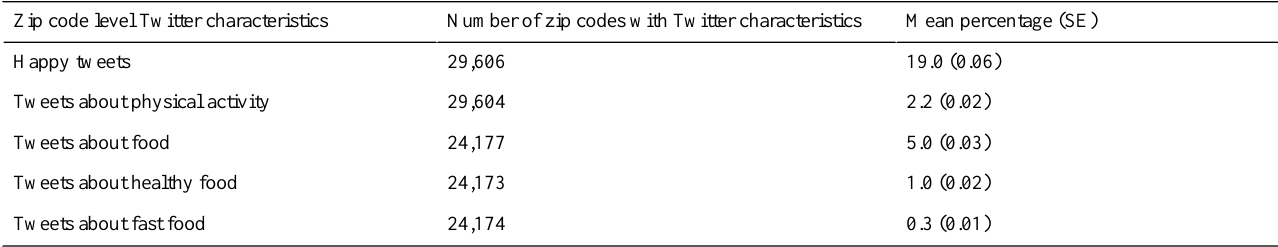
Table 1. Descriptive characteristics for Twitter social neighborhood characteristics.